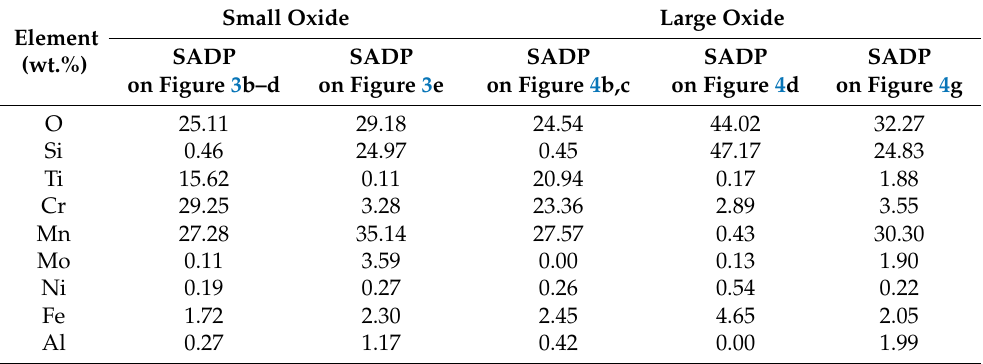
SADP: selected area diffraction pattern of TEM.